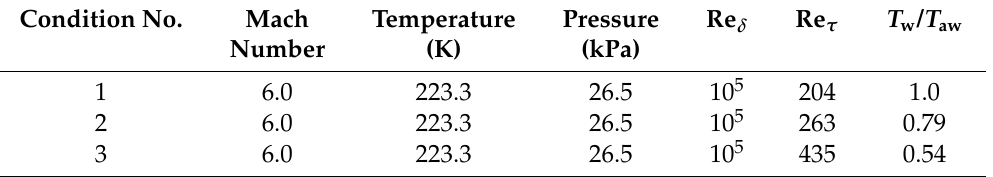
Table 1. Flow conditions.